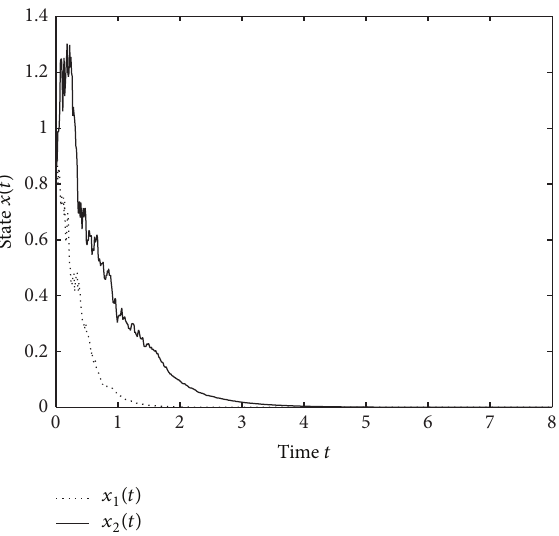
Figure 1: Solution behavior of stochastic